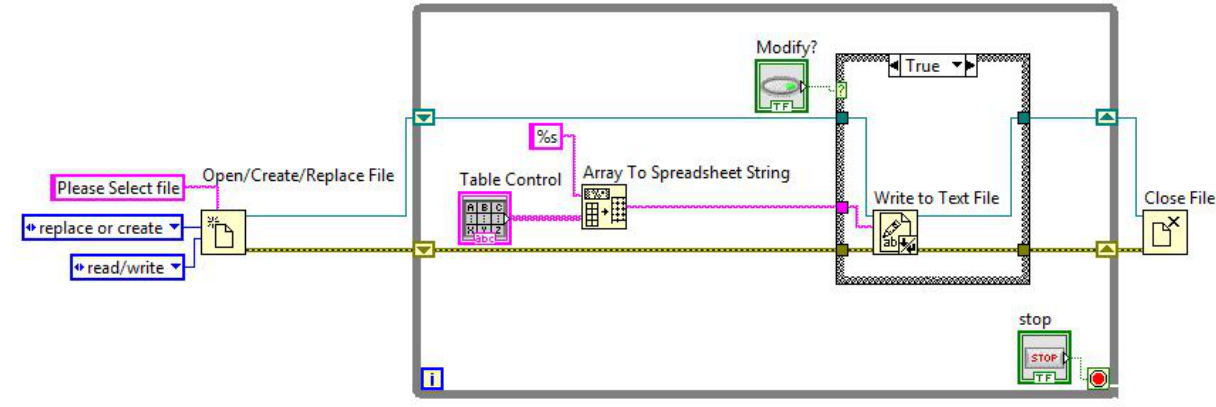
Figure 11. Locations of the MATLAB script nodes in